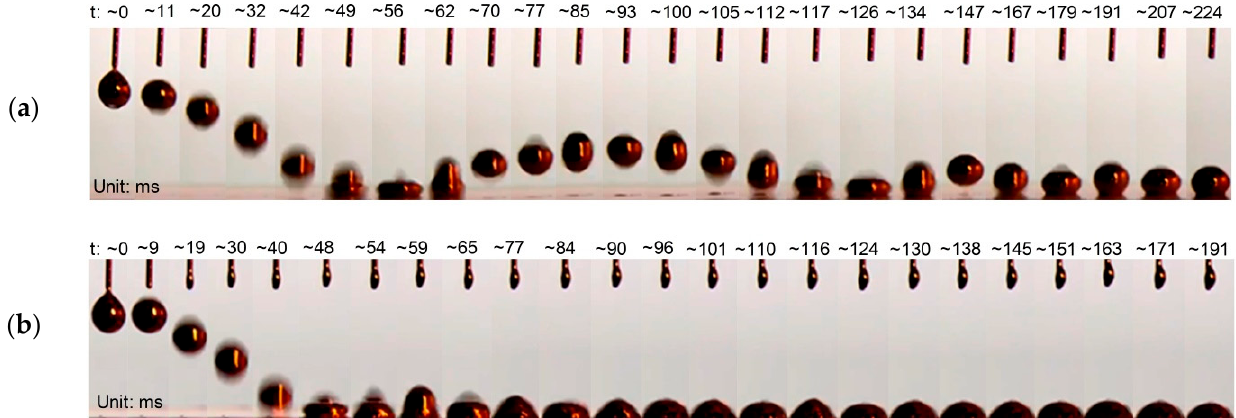
Figure 5. Sequential images of the RGD after being released from a syringe needle, falling and impacting on ( a ) PDMS and ( b ) Au surface.